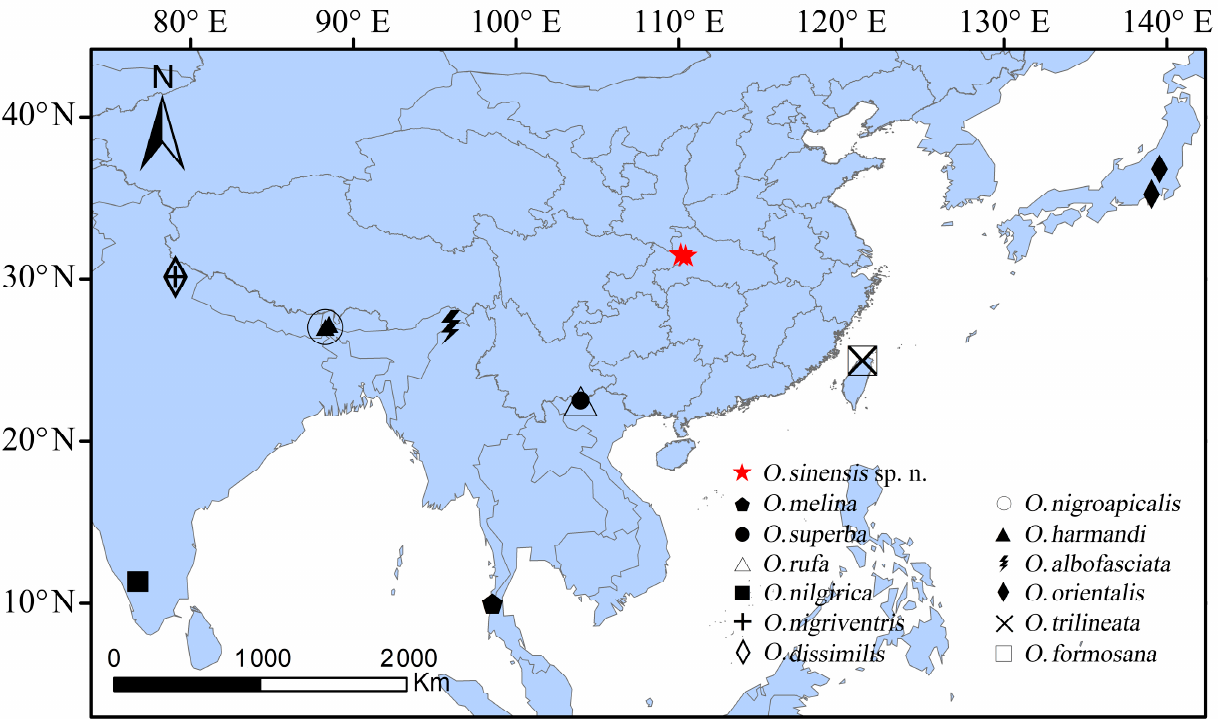
Figure 5. Distribution of the Osphya species in the Oriental and eastern and southern Palaearctic regions.